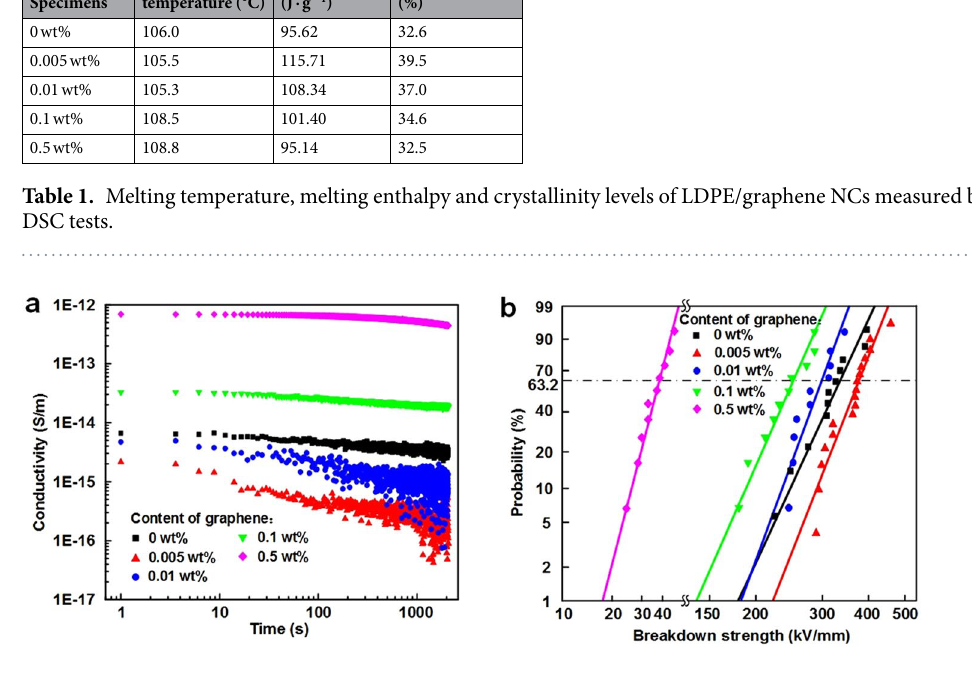
Figure 2. ( a ) DC conductivity of LDPE/graphene NCs as a function of polarization time under 10 kV/mm. ( b ) Weibull distribution of dc breakdown strength of LDPE/graphene